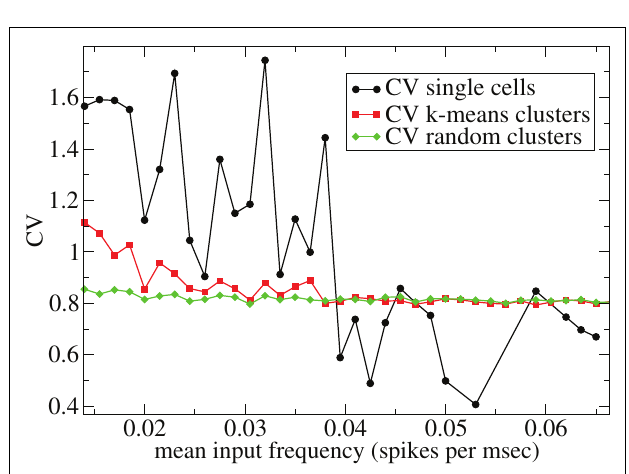
FIGURE 10 | CV 2 distributions corresponding to Figure 9 for all cells combined for different network simulations (see key.)